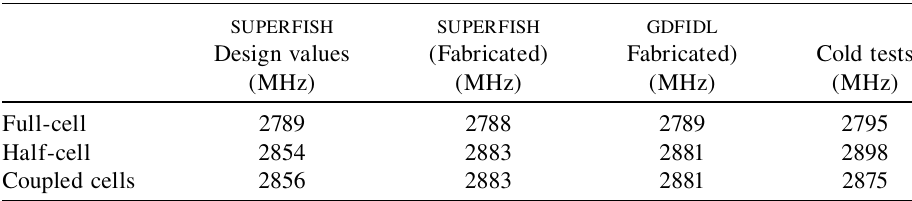
TABLE II. Comparison of the measured and simulated results.